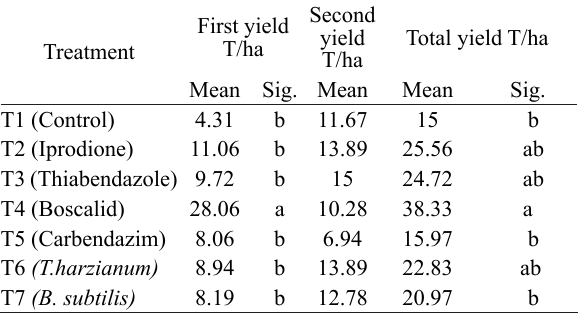
Table 5. Test for first and second yields and total yield with different fungicide treatments with no broccoli addition. (alfa=0.05).